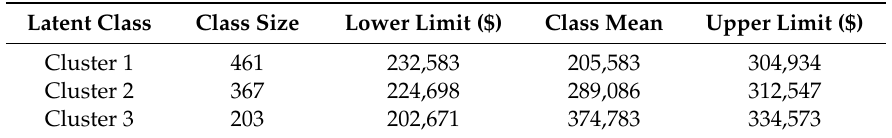
Table 9. Analysis of means at 95% confidence interval.